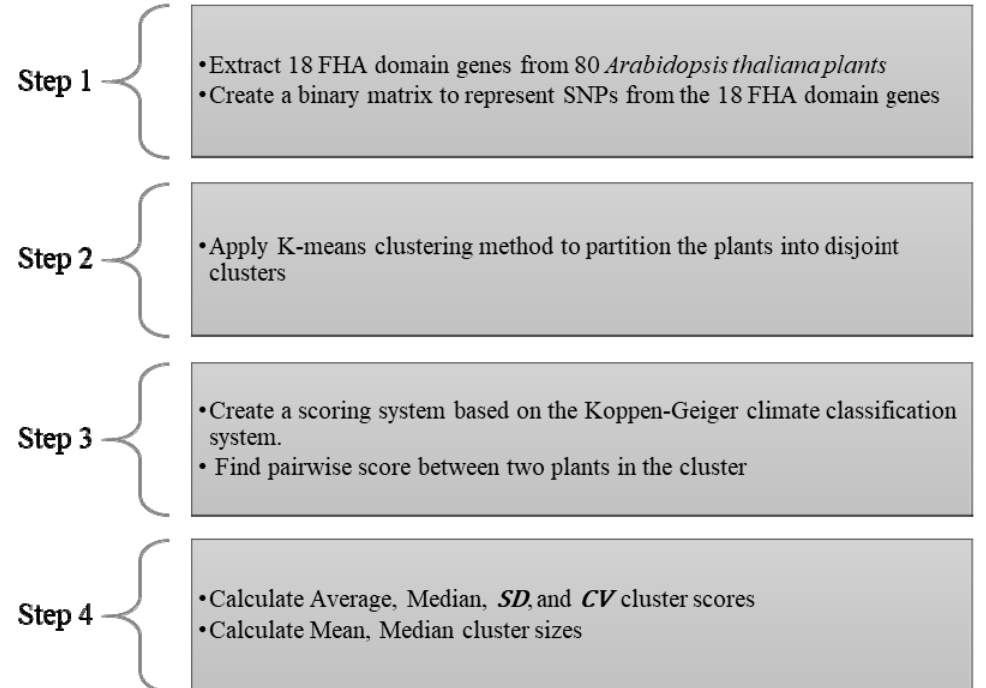
Figure 1. A summary of the steps used to calculate the score and the size of each cluster for the 80 plants at each k-value.